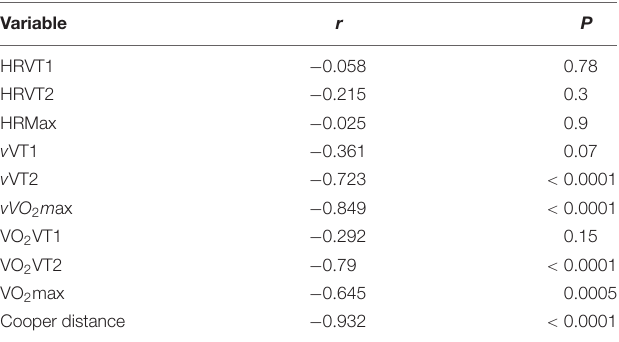
TABLE 4 | Pearson correlation coefficients between half marathon race time and treadmill variables. Variable